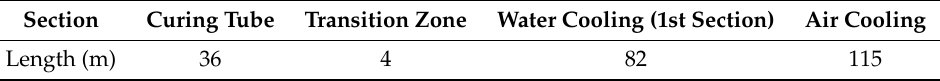
Figure 3. The 132 kV cable specification. Table 1. Continuous vulcanization (CV) line configuration.